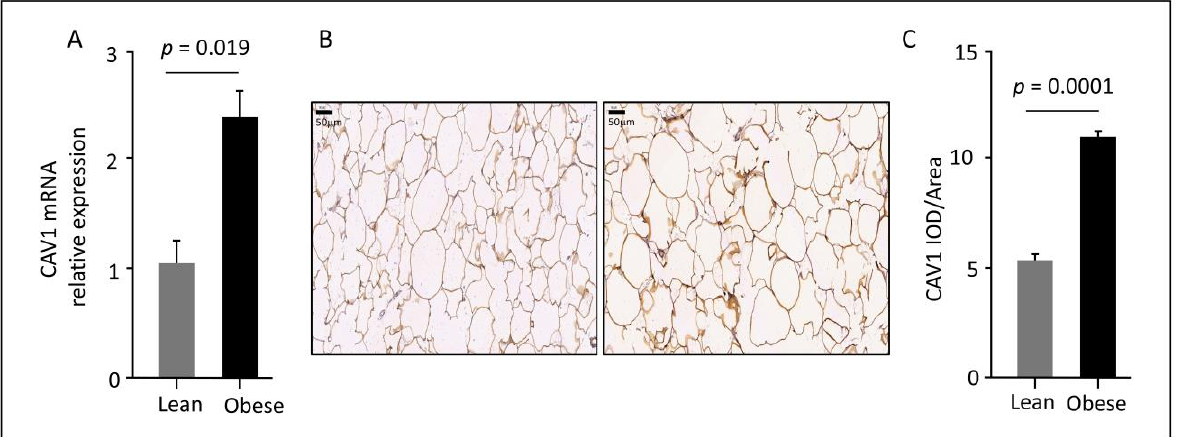
Figure 1. Increased CAV1 mRNA and protein levels in AT. ( A ). CAV1 mRNA expression in AT isolated from lean and obese individuals, as determined by RT-qPCR assay ( B ). Representative images of IHC staining for CAV1 protein in tissue sections of AT obtained from lean and obese individuals. Obese sections show stronger staining than lean sections (images, magnification, ×20). ( C ). IOD/area quantification of CAV1 expression in AT from lean and obese individuals. CAV1 protein expression in obese individuals is two-fold higher, as compared to lean participants. Abbreviations: AT, adipose tissue; CAV1, caveolin-1; IHC, immunohistochemistry; IOD, integrated optical density; RT-qPCR, reverse transcription-quantitative polymerase chain reaction.